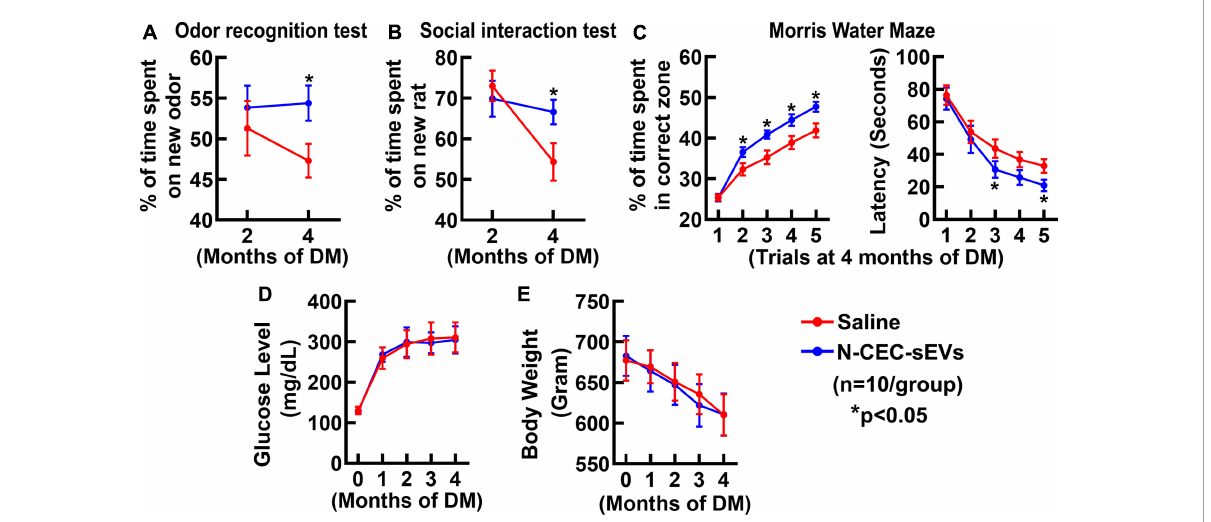
FIGURE4 N-CEC-sEV treatment reduces cognitive deficits in aged DM rats. Odor recognition test (A) , social interaction test (B) , Morris water maze (C) , blood glucose level (D) , and body weight (E) in aged-DM rats treated with saline and N-CEC-sEVs. * P < 0.05 vs. the saline group. N = 10/group.